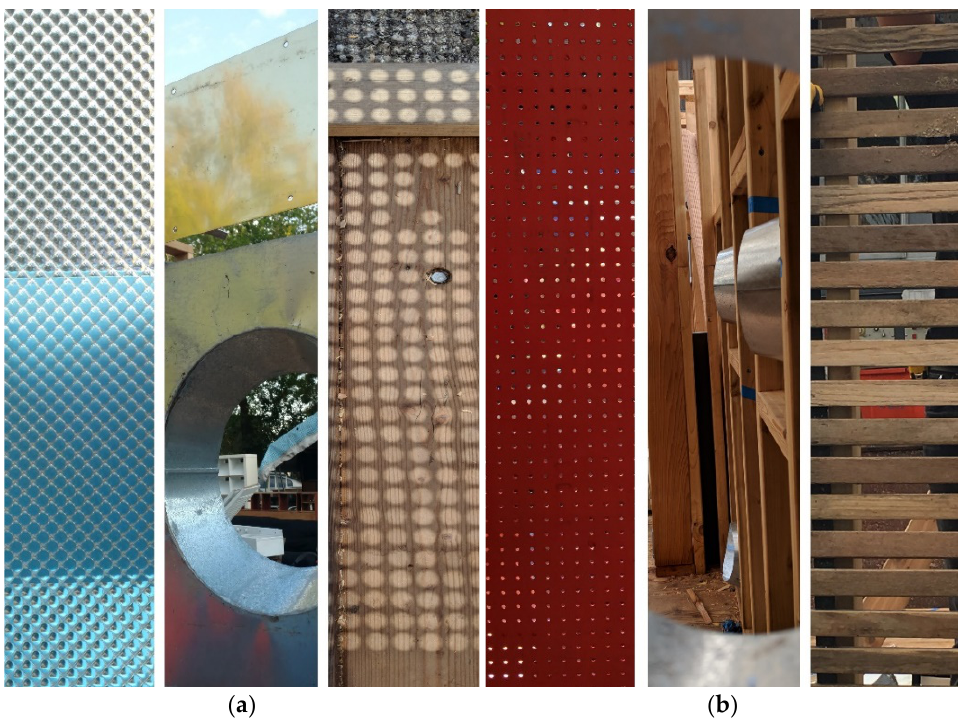
Figure 8. ( a ) Collage 1: Stained Glass (Ana McIntosh), Masked Reflections (Ana McIntosh) and Projected Sky Roberto Moreno (2018); ( b ) Collage 2: Screen (Roberto Moreno), Portals (Roberto Moreno), Horizontal View (Samantha Janolo), in McIntosh and Ryzhikova (2018).